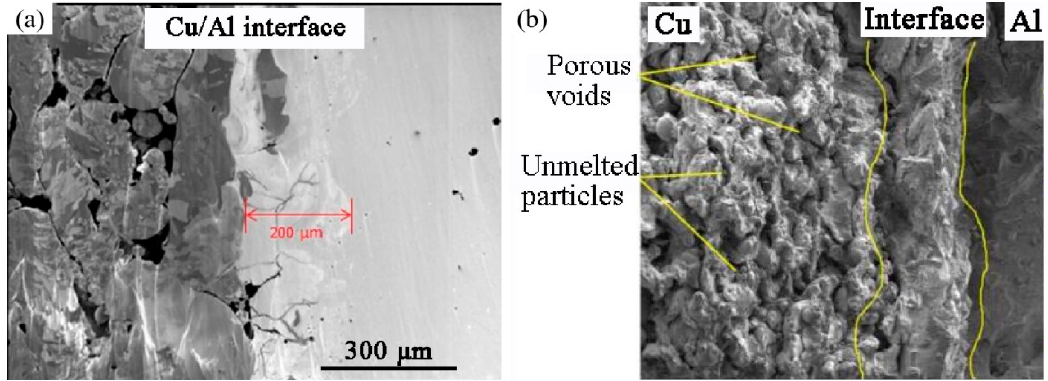
Figure 8. ( a ) Focused ion beam image of LPBF-processed Cu/Al interface; ( b ) Fracture morphology [92].